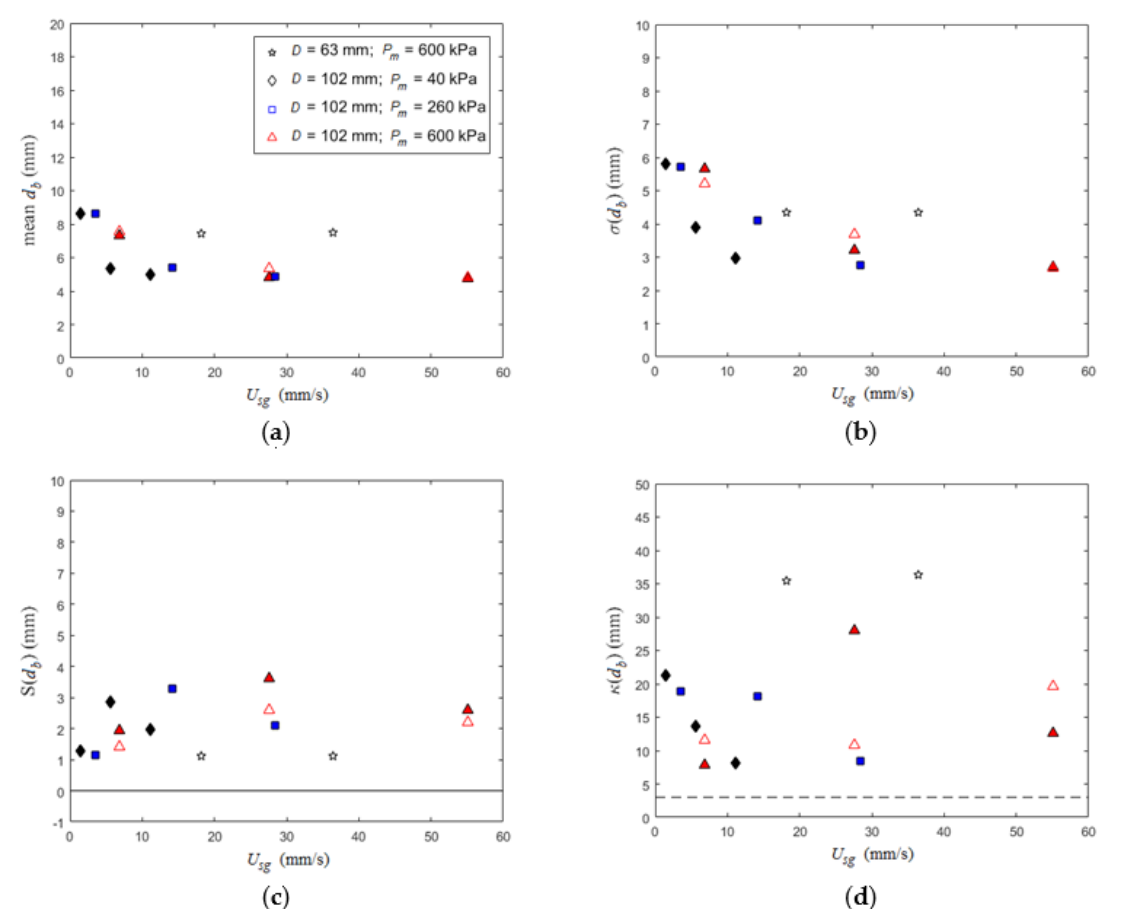
Figure 14. Higher order statistics from the PDFs including ( a ) unweighted mean, ( b ) standard deviation σ , ( c ) skewness S and ( d ) kurtosis κ of the bubble diameter. Dashed line on the kurtosis plot at κ ( d b ) = 3 corresponds to the kurtosis value of a normal distribution. The same legend is used for all plots. Open and closed symbols correspond to d inj = 0.8 and 1.6 mm, respectively.